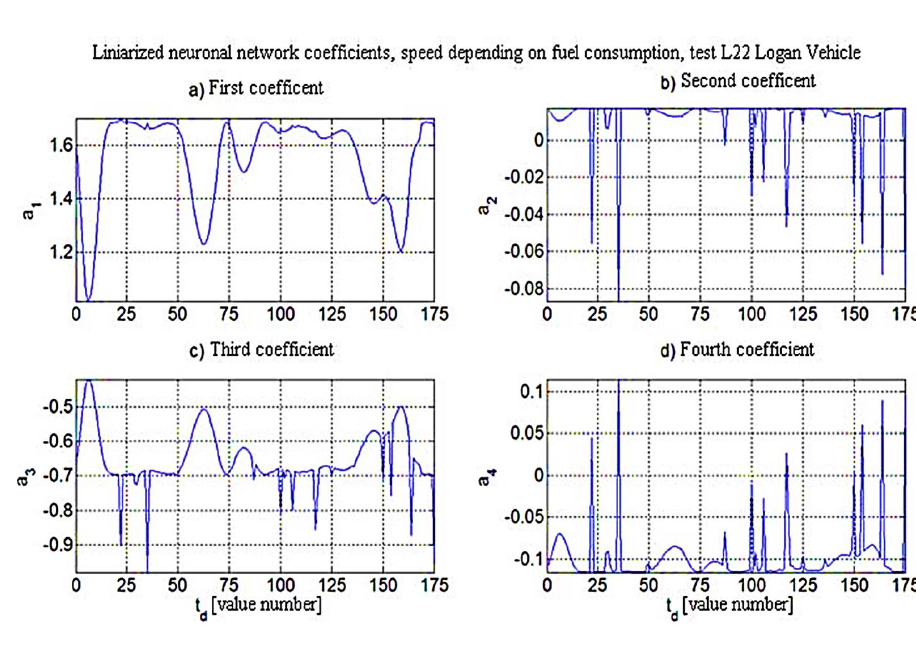
Figure 7. Coefficient